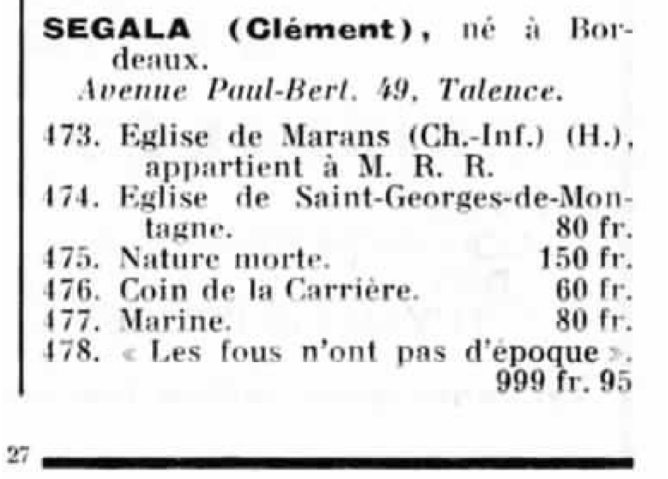
Figure 2. Detail of the Salon des Artistes indépendants bordelais (SAIB) exhibition catalogue, 1930, p.